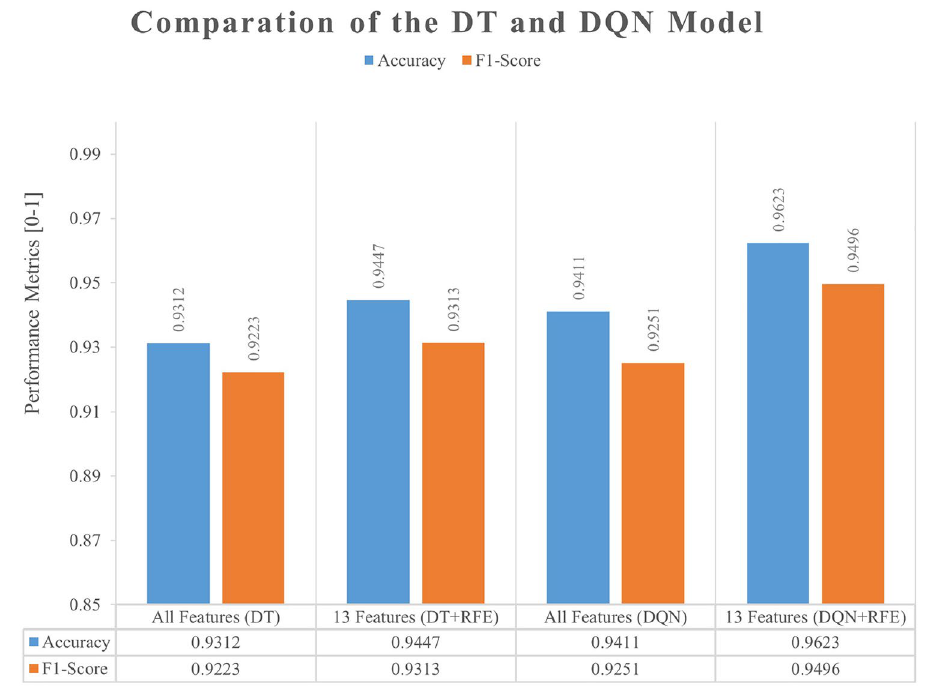
Figure 11. Comparison of the results of two models.